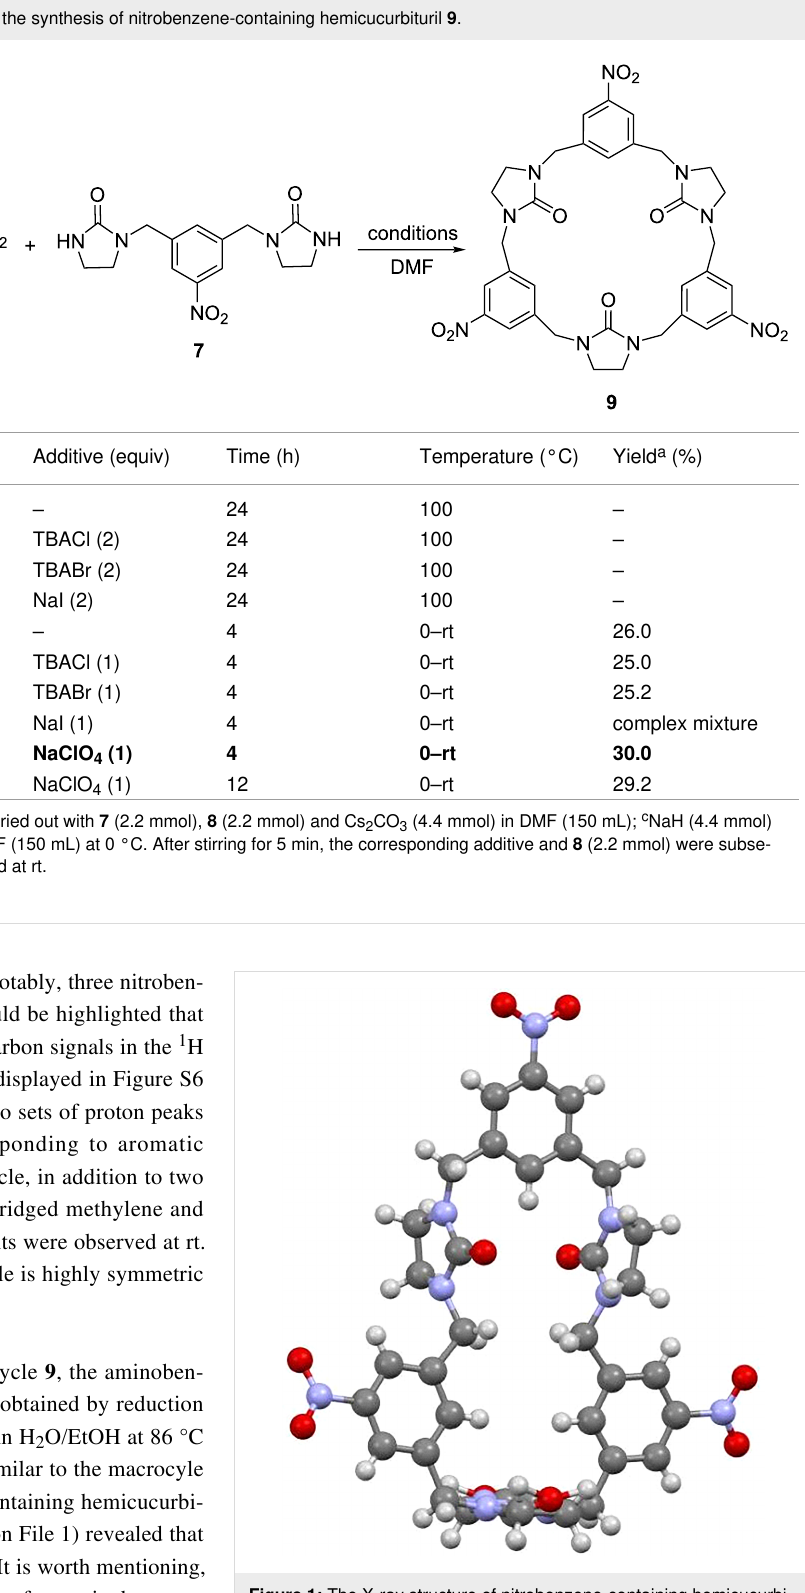
Figure 1: The X-ray structure of nitrobenzene-containing hemicucurbi- turil 9 (CCDC